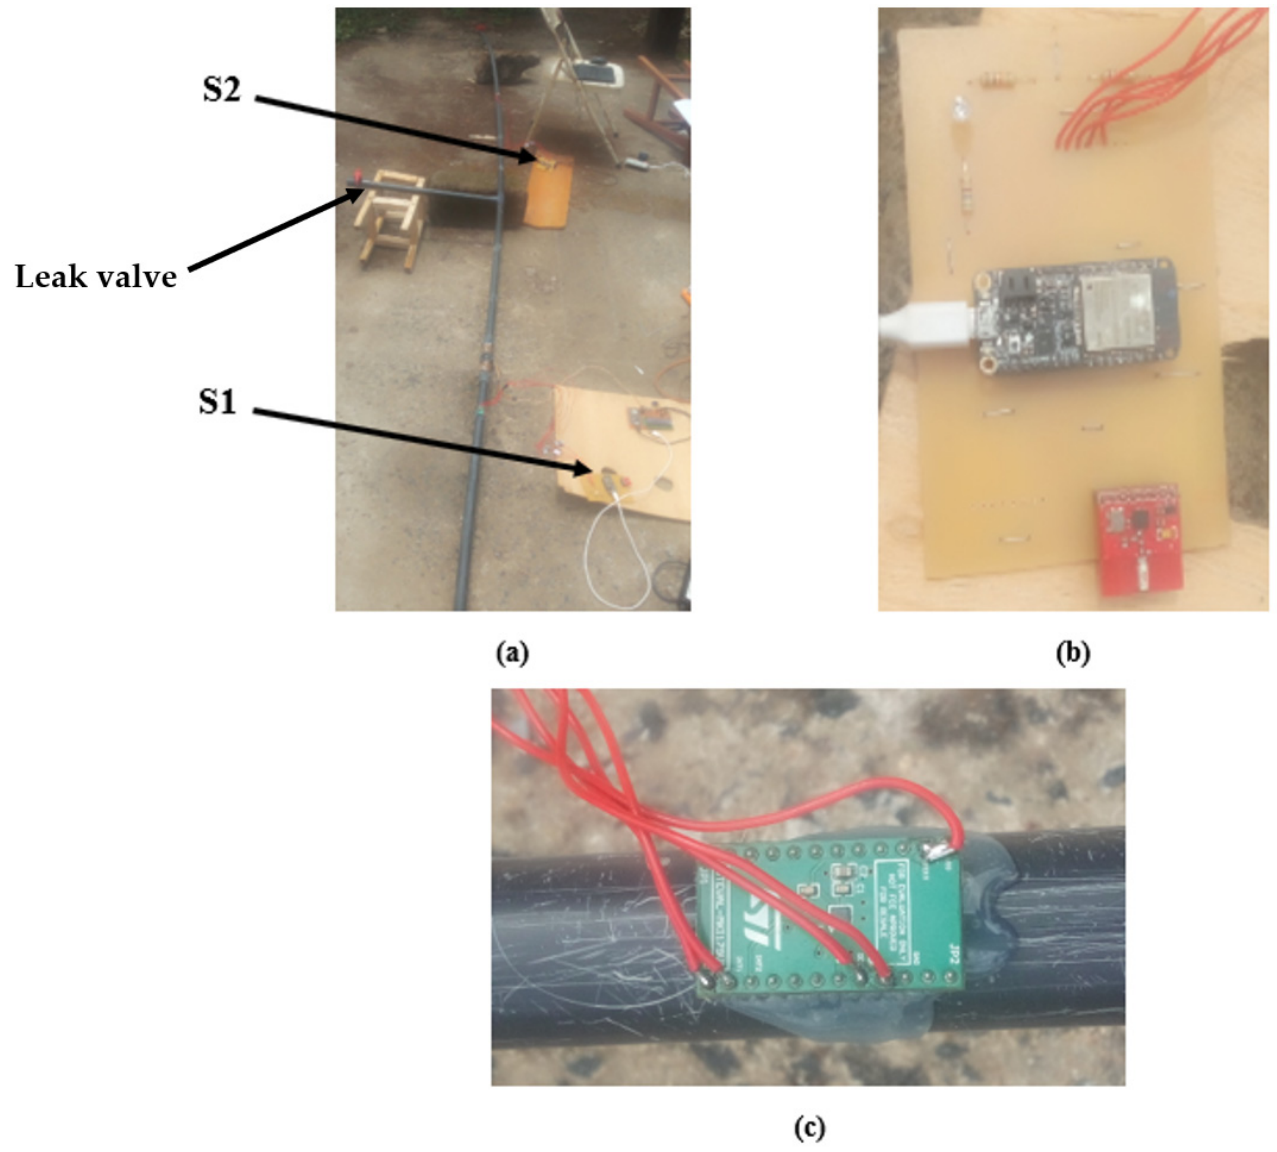
Figure 6. Two-node linear WWPM system: ( a ) position of sensor node’s S1 and S2; ( b ) sensor node on PCB; ( c ) mechanical coupling of the accelerometer to the pipe surface.